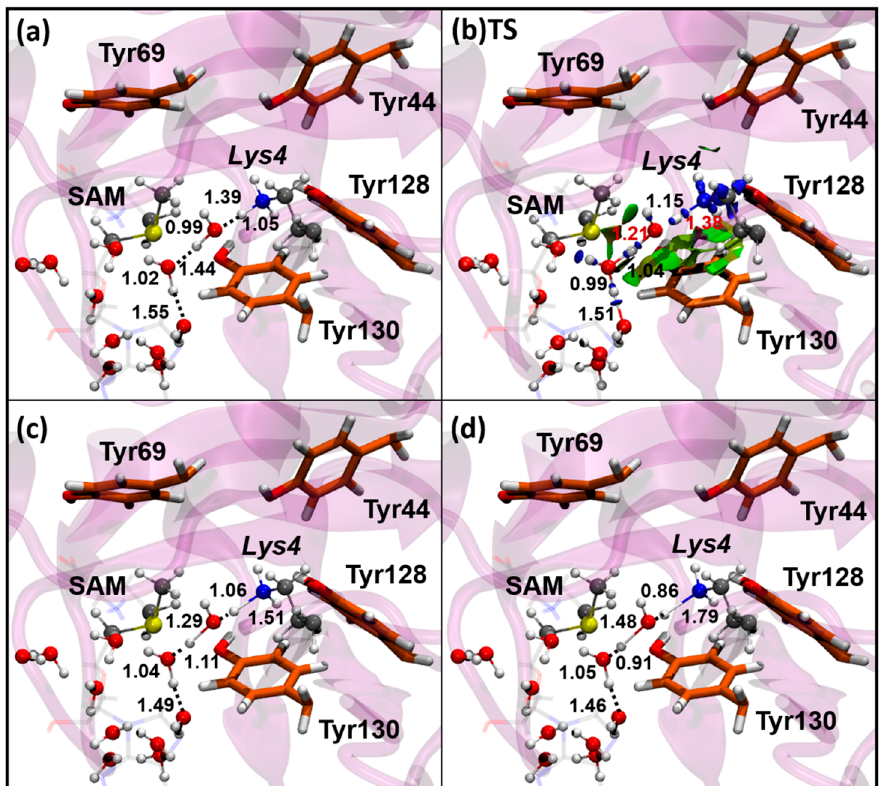
Figure 3. Sequential representation of the evolution through the normal mode associated to the reaction coordinate for the deprotonation process in M3RA. For clarity, only the QM atoms are shown. The evolution of the Lys4(N)-H + bond through the reaction normal mode is represented sequentially from ( a ) to ( d ). The concerted nature of the process is revealed involving three water molecules in the process. The second structure denoted as (b)TS corresponds to the geometry at the transition state of the reaction, where the surface corresponding to the DORI analysis is also included, which reveals the role of Tyr130 in the proper alignment of Lys4-H + and the water channel. (enzyme’s carbon ― orange; substrate and cofactor carbon ― gray; red ― oxygen; blue ― nitrogen; white ― hydrogen and the isovalue used as cutoff for the surface was defined at 0.5).